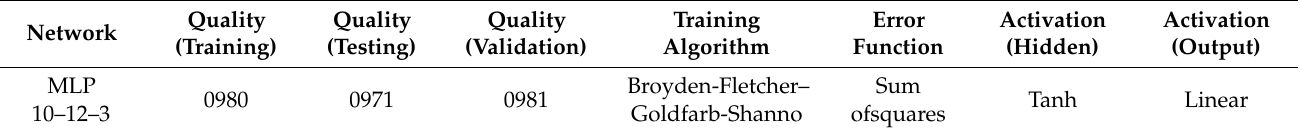
Table 3. Artificial neural networks operation